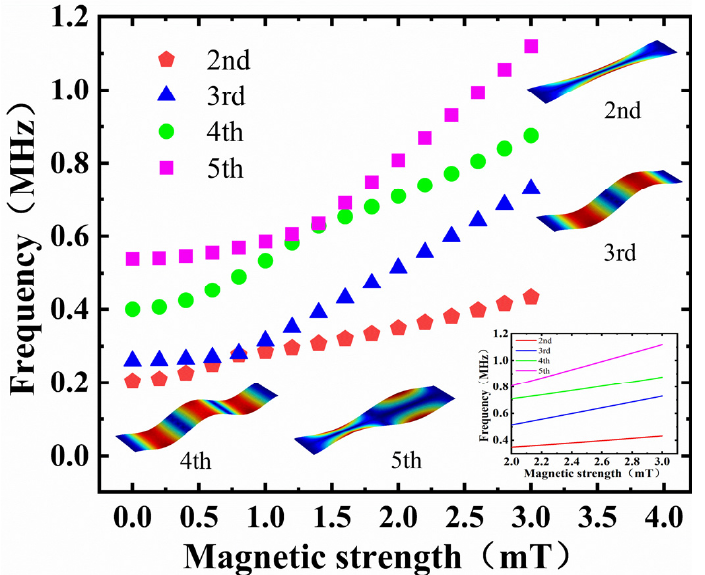
Figure 8. The second to fifth natural frequencies of the magnetic sensor changes versus the magnetic field. The inset shows the fitted curve of 2–3 mT.